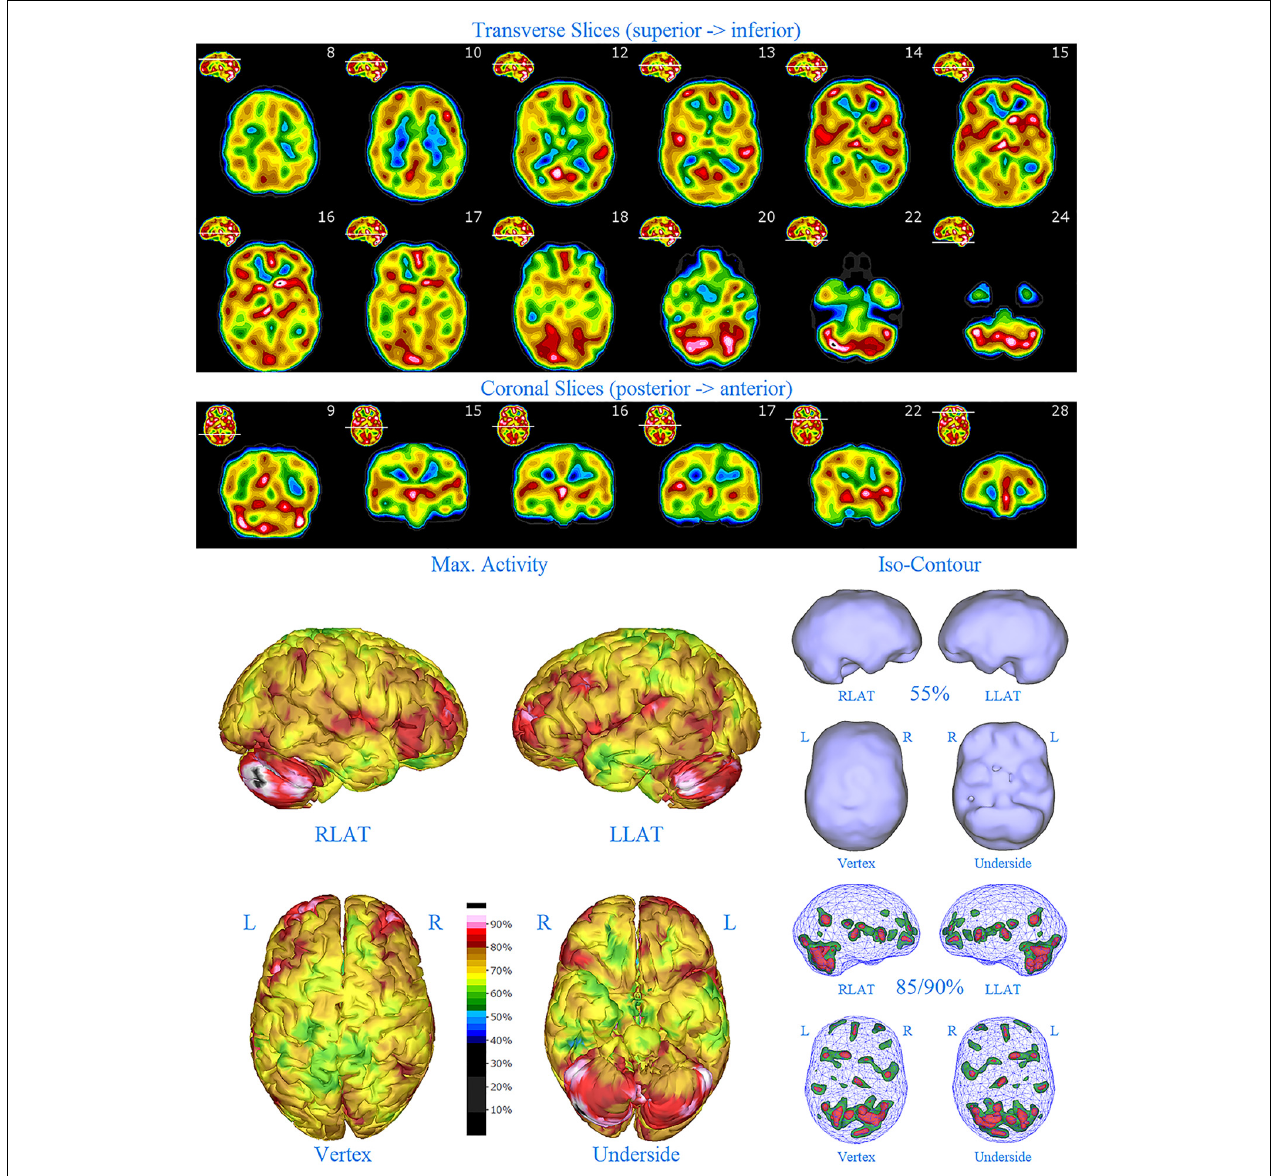
FIGURE 3 | Perfusion SPECT scan of Patient B. Arrangement, color scales, and views are identical to Figure 1 . Anatomical structures such as the thalamus are positioned similarly to the scan shown in Figure 2 . Labeling was eliminated to avoid obscuring the scan details. Perfusion of the thalamus is increased and asymmetrical. Perfusion is markedly increased in the left caudate. Multiple cortical areas of increased perfusion are evident, predominately in the frontal